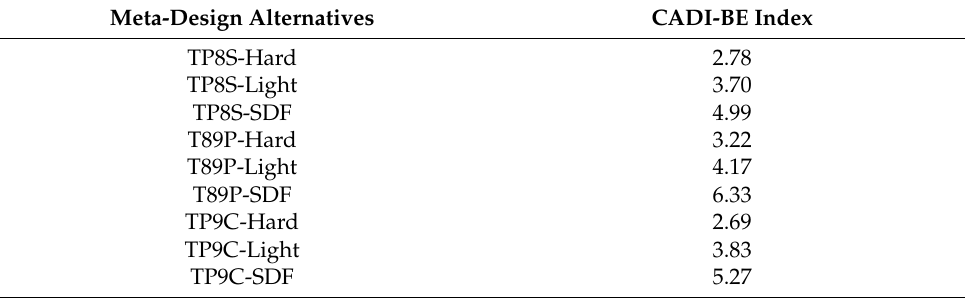
Table 5. Comparison of PMV average values: absolute reduction and percentage.